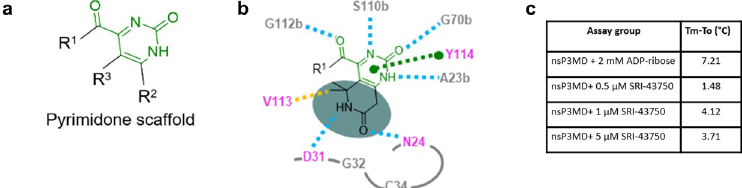
Fig 6. Fragment-based in silico design and thermal shift assay. a) Definition of the fragment scaffold. b) An ideal compound of R 2 and R 3 according to receptor-structure-based design. The residues on nsP3MD interacting with the compound are highlighted. The hydrogen bonds are labelled with cyan dashed lines. The π - π interaction is highlighted with a green dashed line. The hydrophobic interaction is highlighted with an orange dashed line. Residues which are highlighted in purple are critical for CHIKV viral replication. c) Thermal shift assay of nsP3MD with ADP-ribose and SRI-43750. The T is the melting temperature in the presence of ADP-ribose and SRI-43750 while T m temperature of nsP3MD